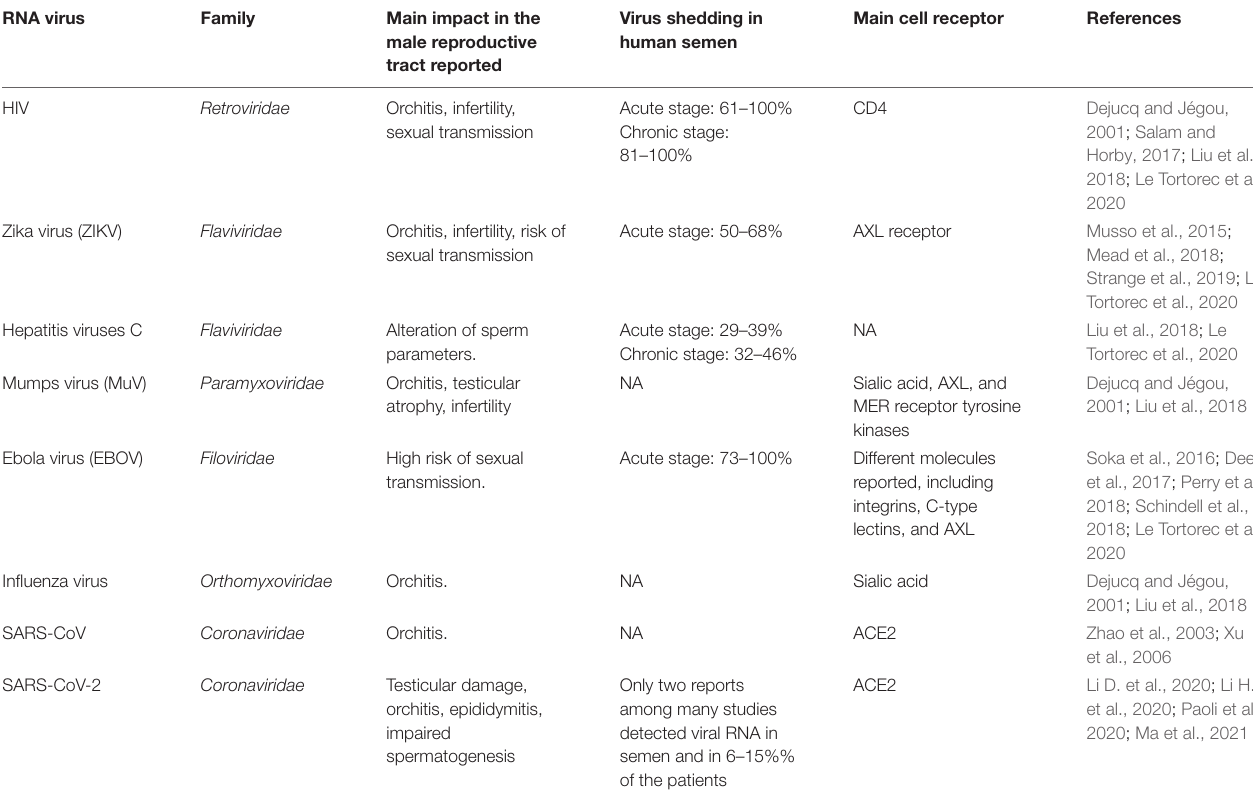
TABLE 1 | Major RNA viruses found in the male reproductive tract, their consequences, and cell receptors used for viral